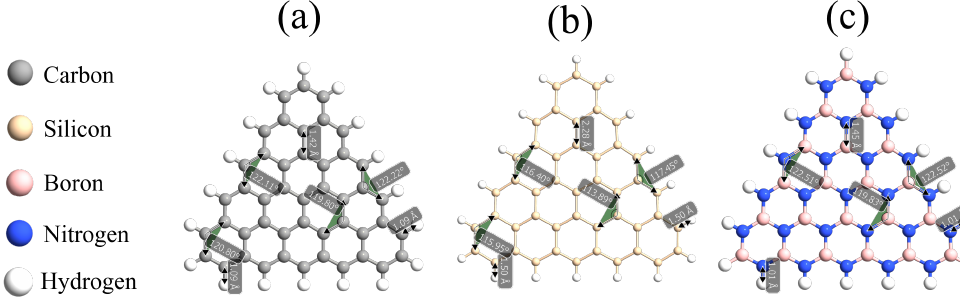
Figure 8. The optimized and minimized structure of the ( a ) graphene, ( b ) silicene, and ( c ) h-BN zigzag trigonal nanodiscs with a width of N =